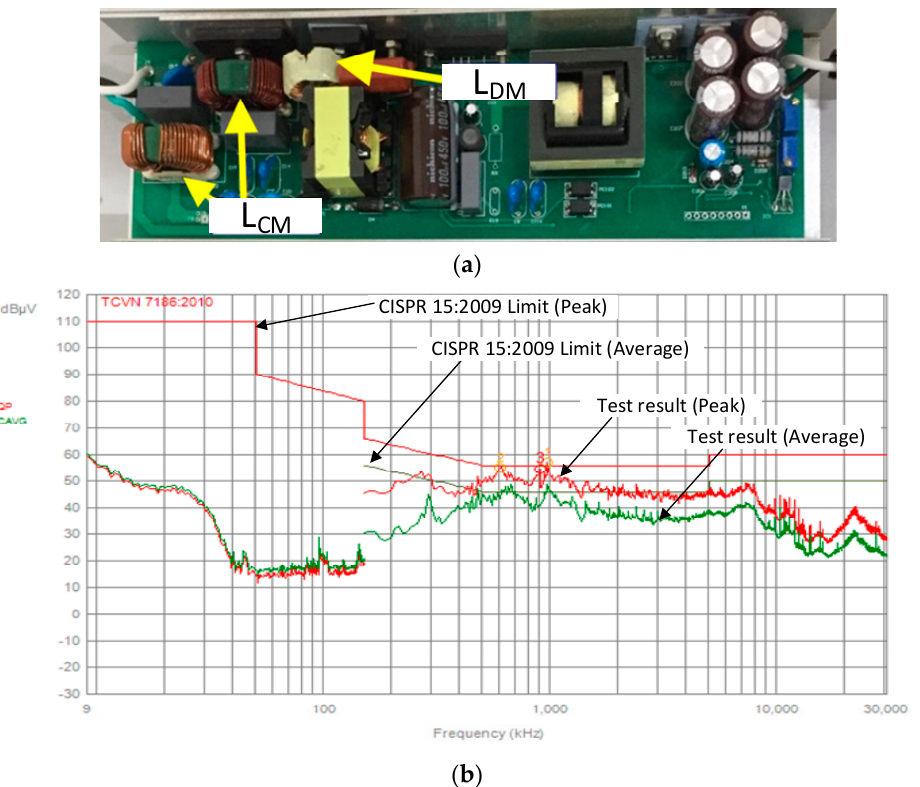
Figure 16. ( a ) The 150 W ‐ based two ‐ stage LED driver using EMI filter with discrete L CM and L DM . ( b ) EMI frequency spectrum.